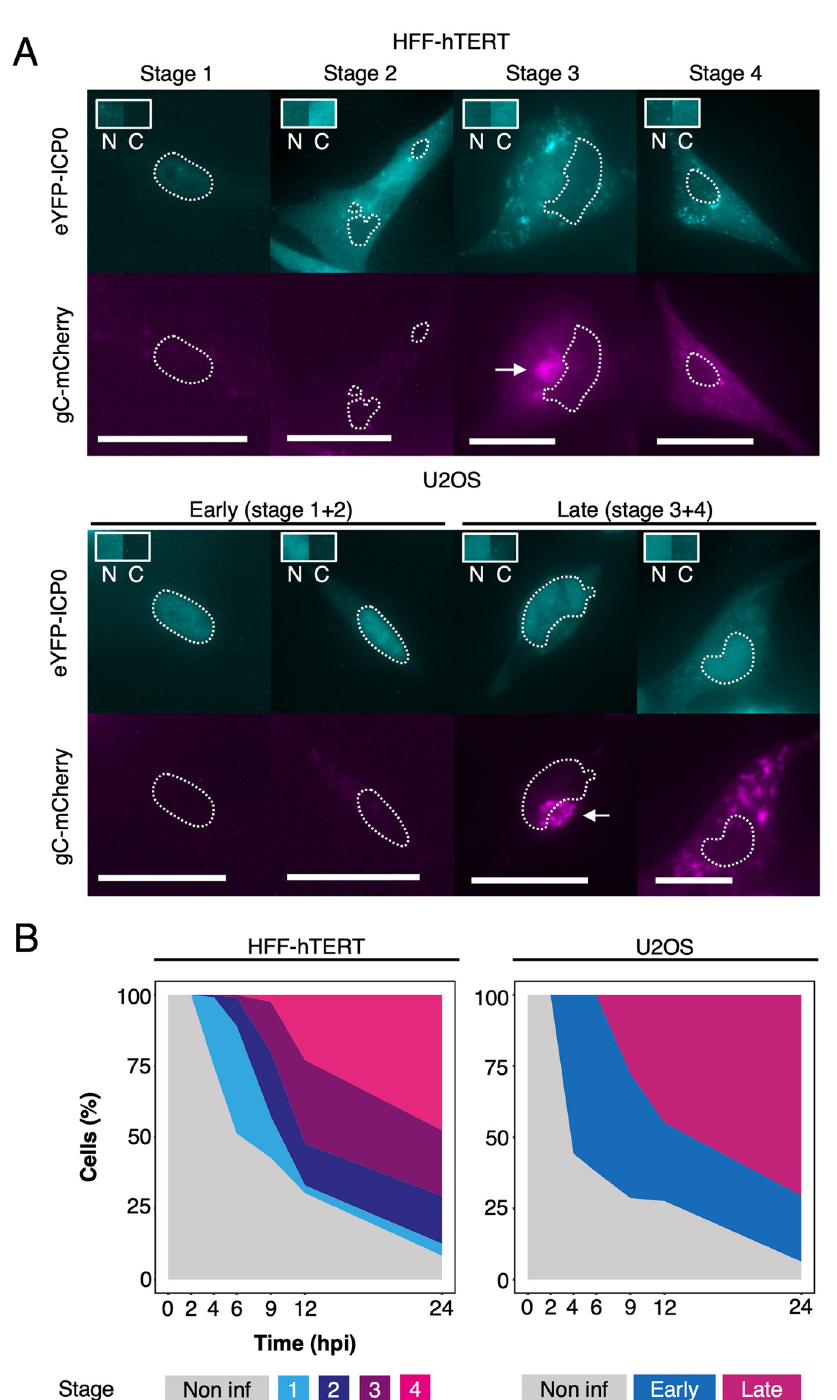
Fig 2. Temporal analysis of HSV-1 infection using the dual-fluorescent timestamp virus. ( A ) Room temperature widefield fluorescence imaging of timestamp HSV-1 infected HFF-hTERT and U2OS cells was used to delineate between stages of infection based on the expression and localization of the early protein eYFP-ICP0 and the late protein gC-mCherry [16]. The spatiotemporal expression of these fusion proteins was similar in HFF-hTERT and U2OS cells, except for increased retention of eYFP-ICP0 in the nucleus of U2OS cells during all stages. Outlines show the nuclei and arrows indicate juxtanuclear compartments rich in gC-mCherry. Scale bars = 50 μ m. Boxes show a sample of the eYFP-ICP0 intensity from the nucleus (N) and cytoplasm (C). ( B ) The proportion of infected cells in each stage was determined using widefield imaging at 2, 4, 6, 9, 12, and 24 hpi following infection (MOI 3) of HFF- hTERT and U2OS cells with timestamp